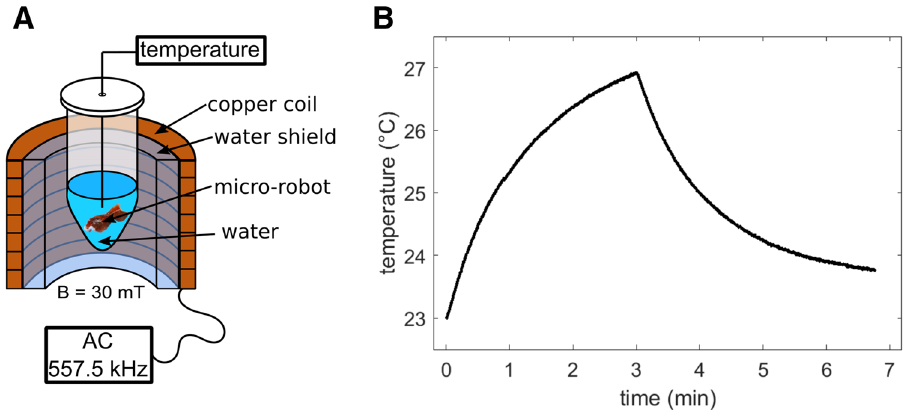
Figure 6. Hyperthermia measurement. ( A ) A schematic drawing of the hyperthermia setup. The micro- robot was covered with water inside an Eppendorf tube. An oscillating magnetic field of 30 mT amplitude and 557.5 kHz frequency was applied for 3 min. ( B ) The temperature of the water, surrounding the micro-robot is